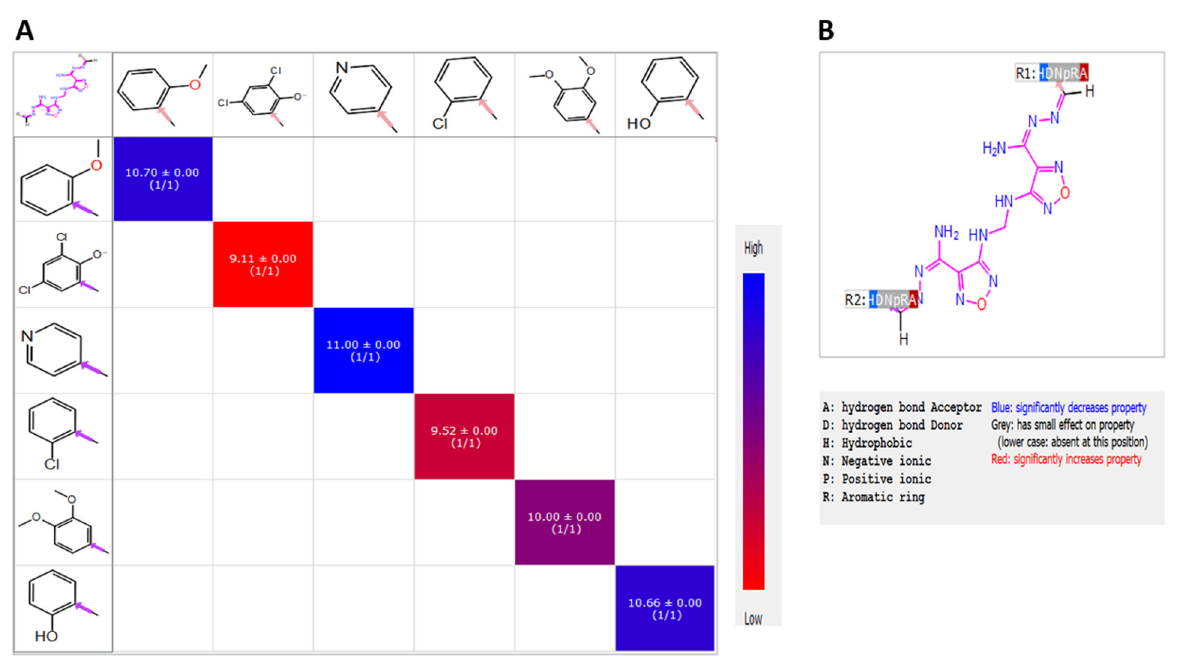
Figure 19. SAR Heatmap analysis. ( A ) PIC 50 values were displayed as colors ranging from red to blue, as shown in the key. ( B ) QSAR analysis, and pharmacophoric features were displayed as colors of red, grey, and blue as shown in the key.